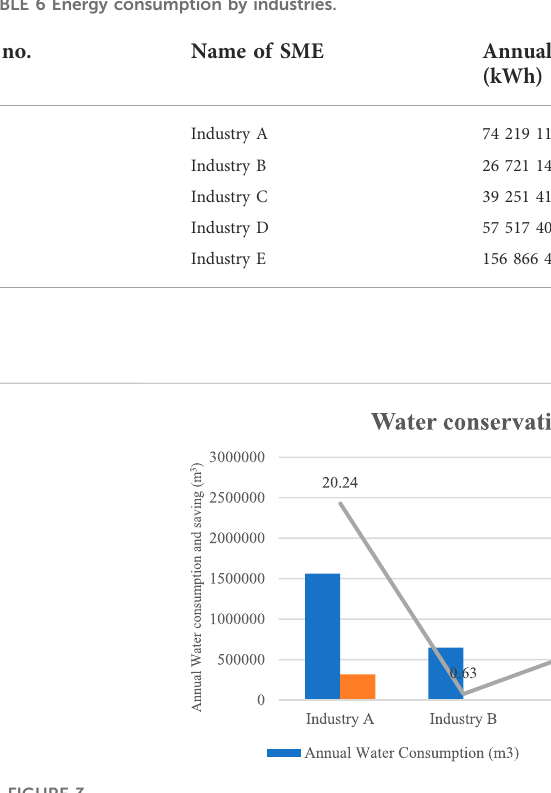
TABLE 6 Energy consumption by